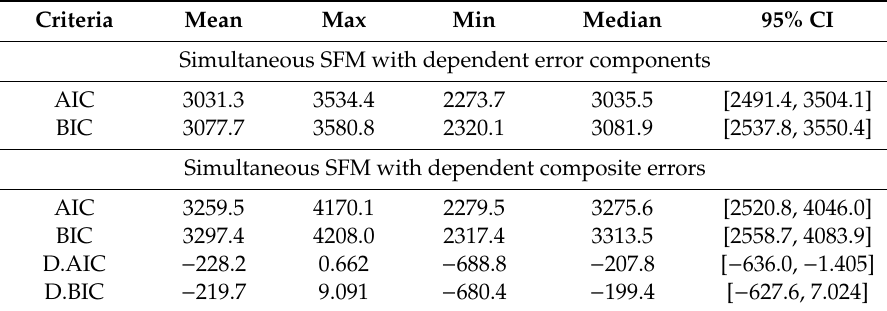
Table 2. Summary statistics of AIC and BIC of two copula-based simultaneous SFM.